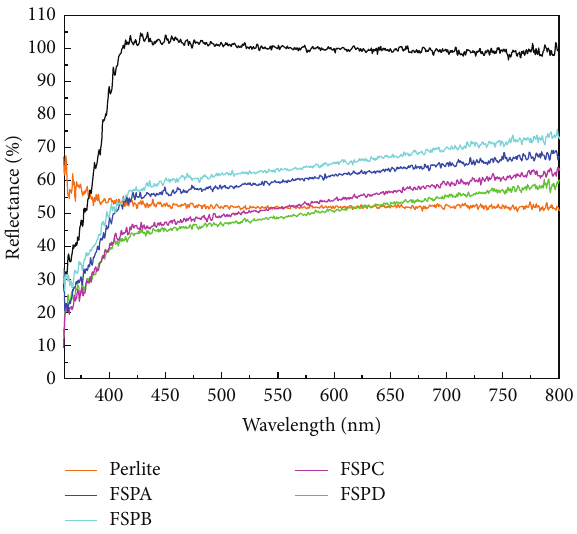
Figure 4: Diffuse reflectance spectra of TiO 2 /perlite